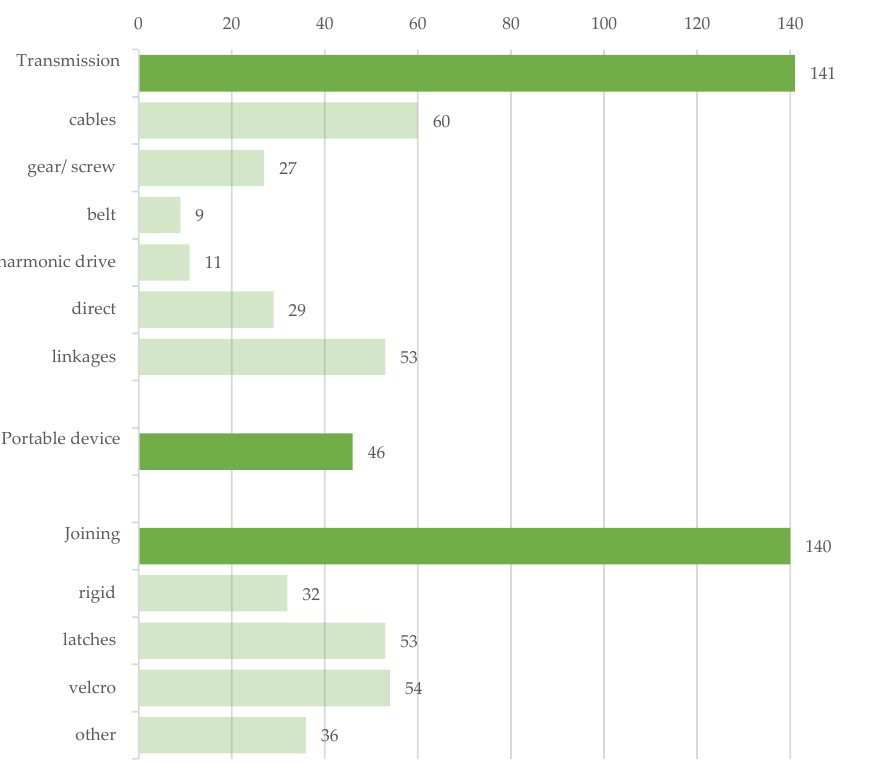
Figure 12. The distribution of exoskeletons by design solutions. Among transmissions, cables and linkages are prevalent with similar percentages values (around 40%). Latches and velcro are almost equally used, with a percentage of about 38%.